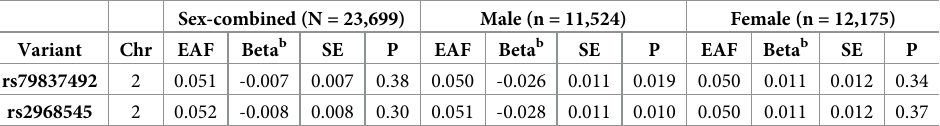
Table 5. The association between lead significant variants associated with visceral fat volume (cm 3 ) in the UK Biobank a . Sex-combined (N = 23,699) Male (n = 11,524) Female (n = 12,175) Variant Chr EAF Beta b SE P EAF Beta b SE P EAF Beta b SE P rs79837492 0.051 -0.007 0.007 0.38 0.050 -0.026 0.011 0.019 0.050 0.011 0.012 0.34 rs2968545 0.052 -0.008 0.008 0.30 0.051 -0.028 0.011 0.010 0.050 0.011 0.012 0.37 a adjusted for body mass index, age, sex, and principal components 1–4. b log unit change per allele